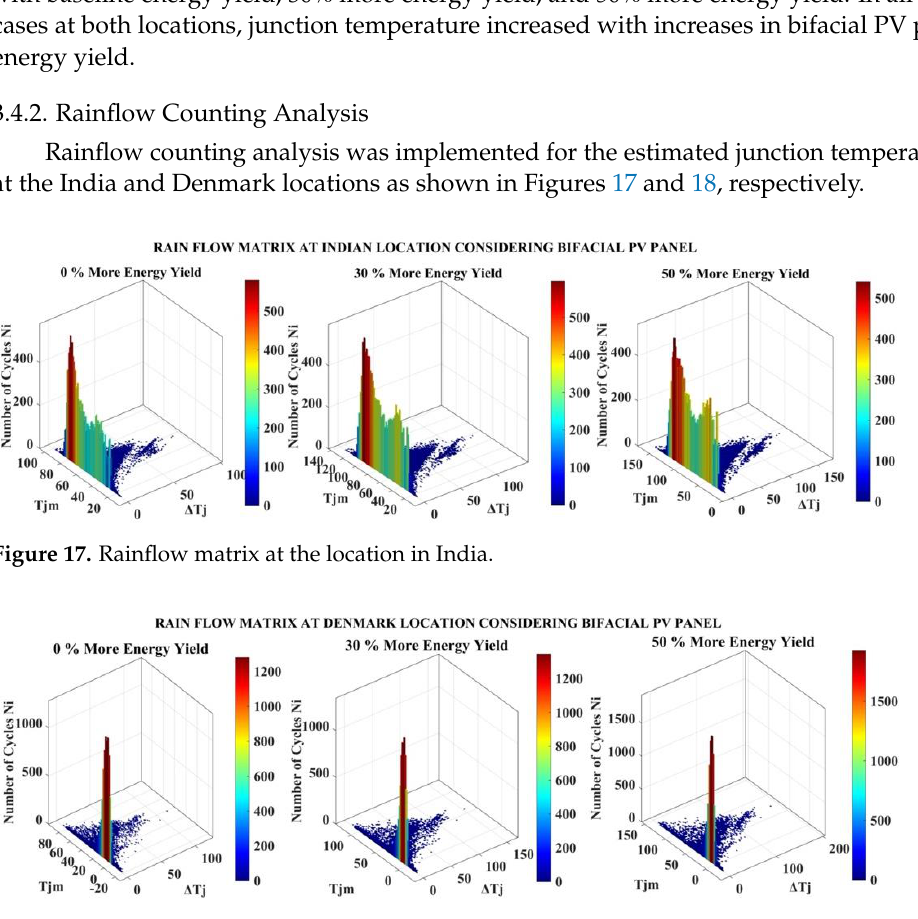
Figure 18. Rainflow matrix at the location in Denmark.